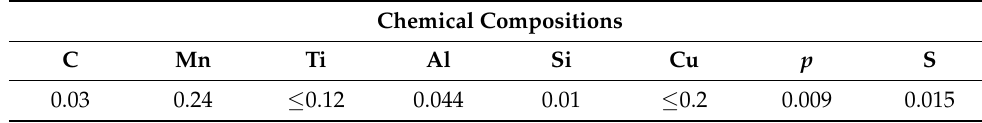
Table 1. Chemical compositions (wt. %) of the BH 220 steel.